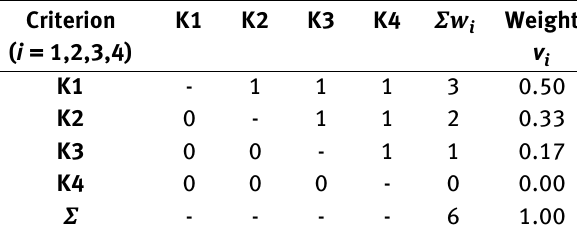
Table 2: Standardization of individual criteria weights [author].